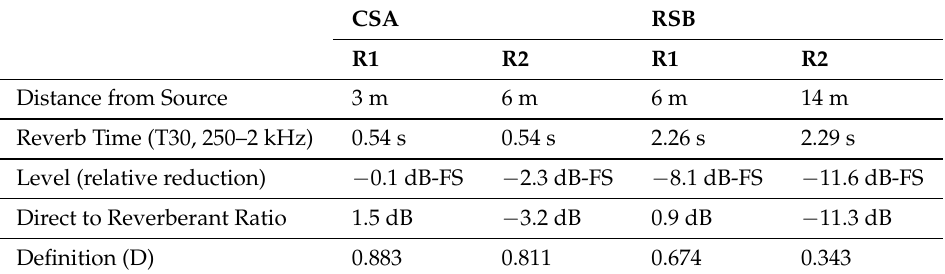
Table 2. Comparison of acoustical metrics from IR measurements in Columbia Studio A (CSA), and Rochester Savings Bank (RSB). Metrics (computed in EASERA) selected for relevance to auditory distance cues. CSA RSB R1 R2 R1 R2 Distance from Source 3 m 6 m 6